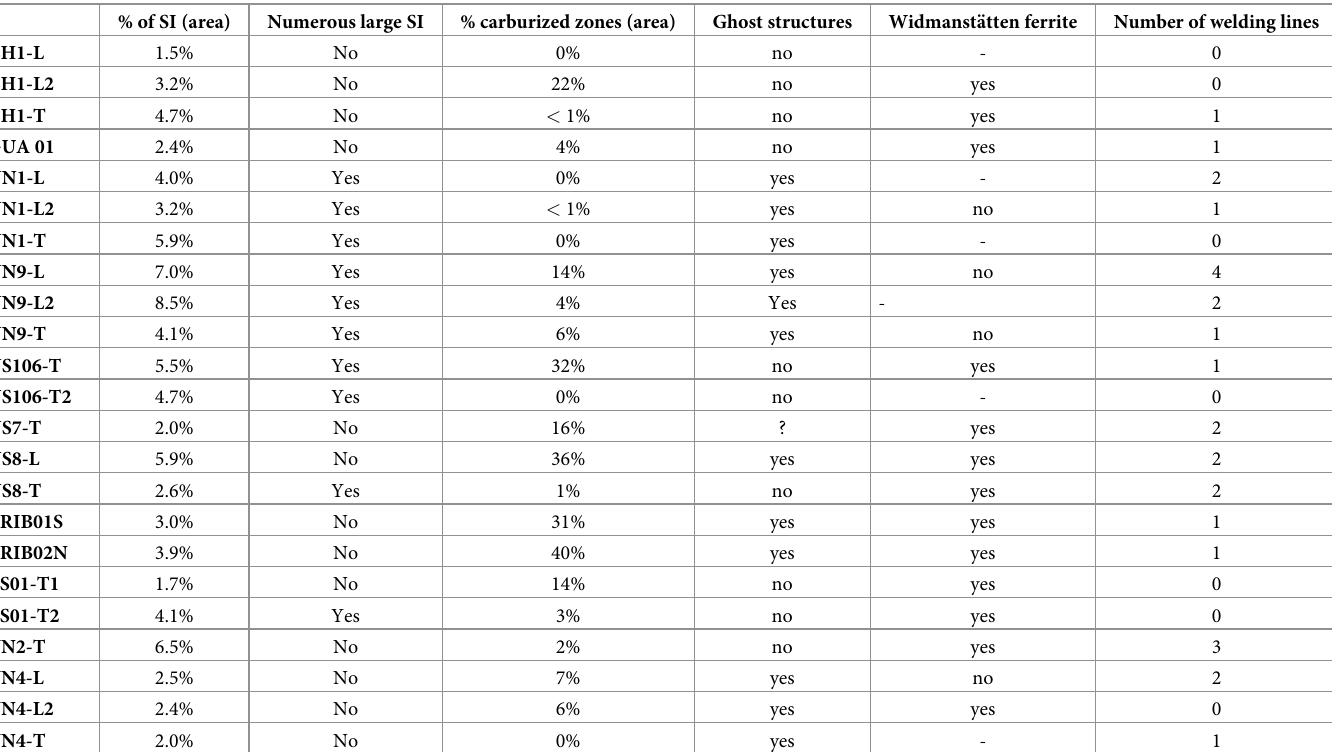
Table 3. Results of metallographic